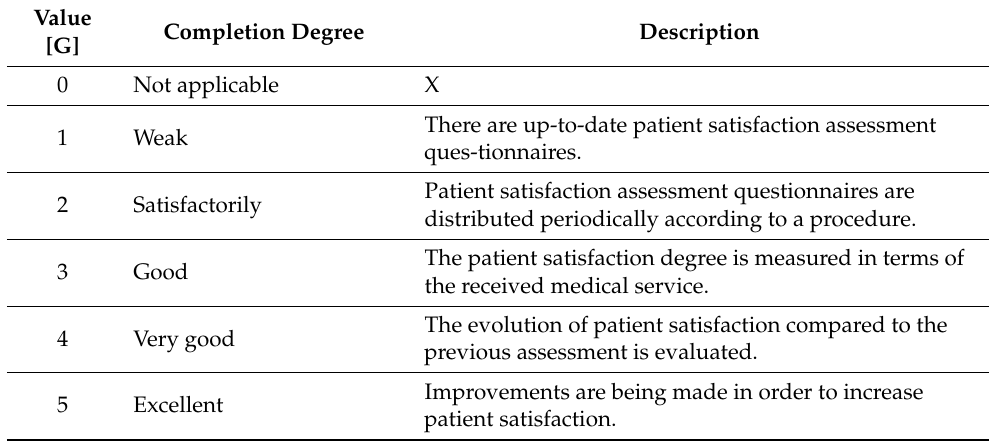
Table 16. Indicator evaluation grid E.B.2—Patient satisfaction